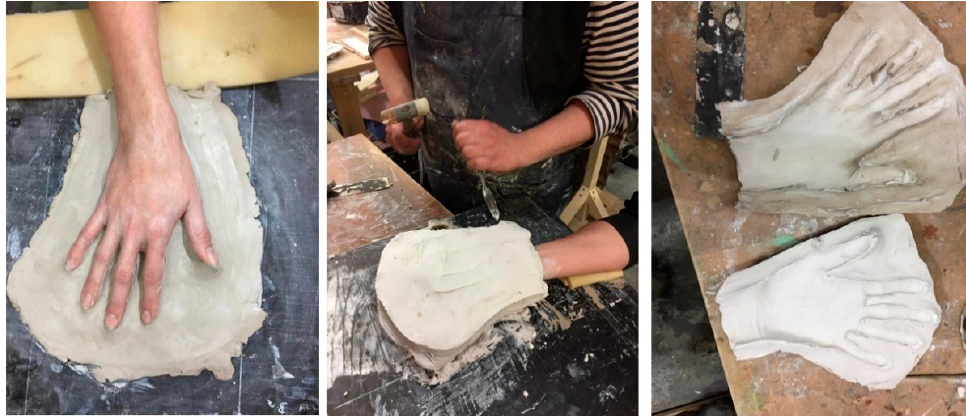
Figure 4. The process of making a hand replica by a professional sculptor.